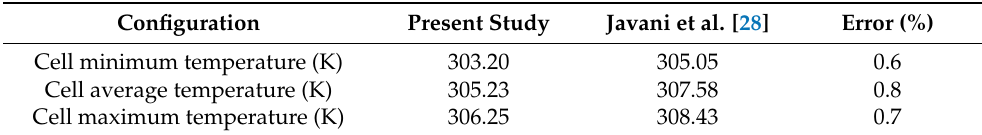
Table 3. Comparison of maximum temperature for the validation of the battery model at 20